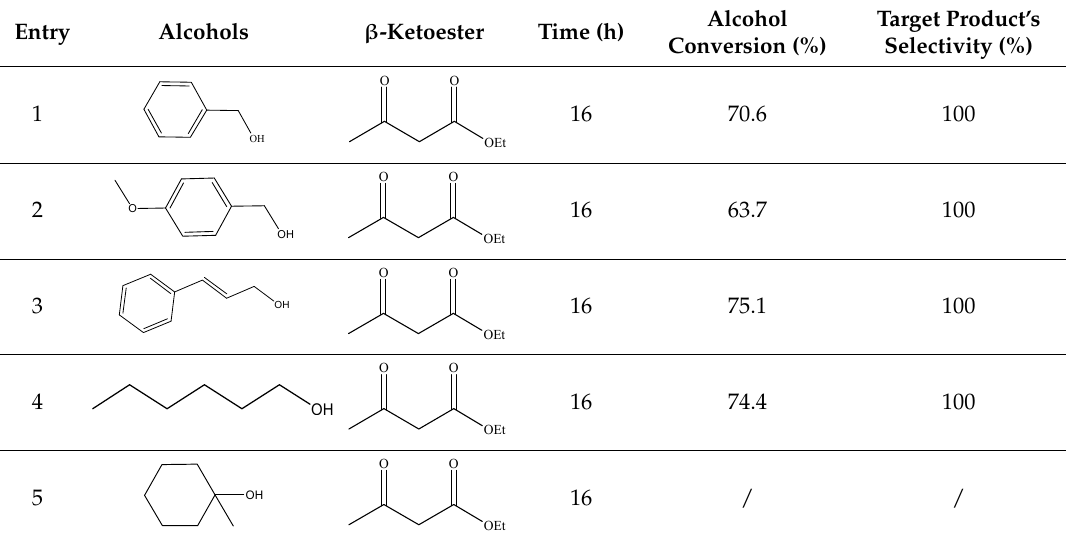
Table 5. Transesterification reactions catalyzed by BSNC-700-tBu (0.1 M).